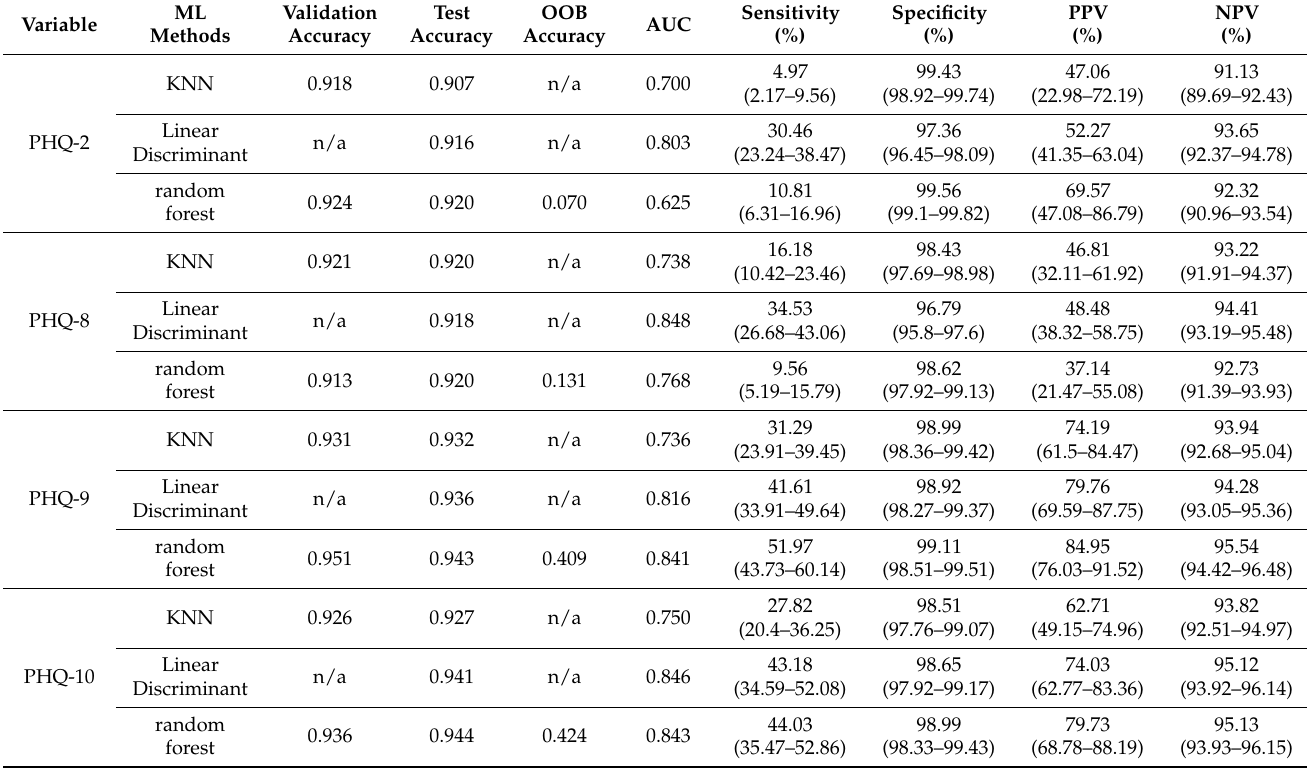
Table 3. Diagnostic characteristics of suicidal ideation assessment using PHQ Item combination by ML technique.